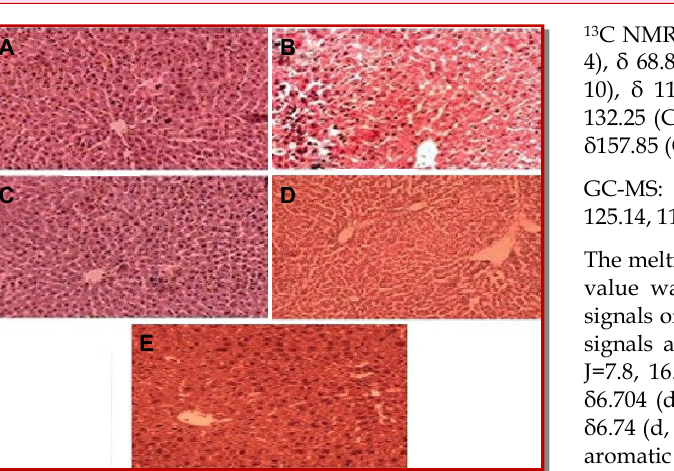
Figure 1: Histological architecture of liver of control and ex- perimental rats A: Normal control; B: Carbon tetrachloride; C: Silymarin treated; D: Ethanol extract of Trichodesma sedgwickianum - treated (200 mg/kg), E- Extract-treated (400 mg/kg)